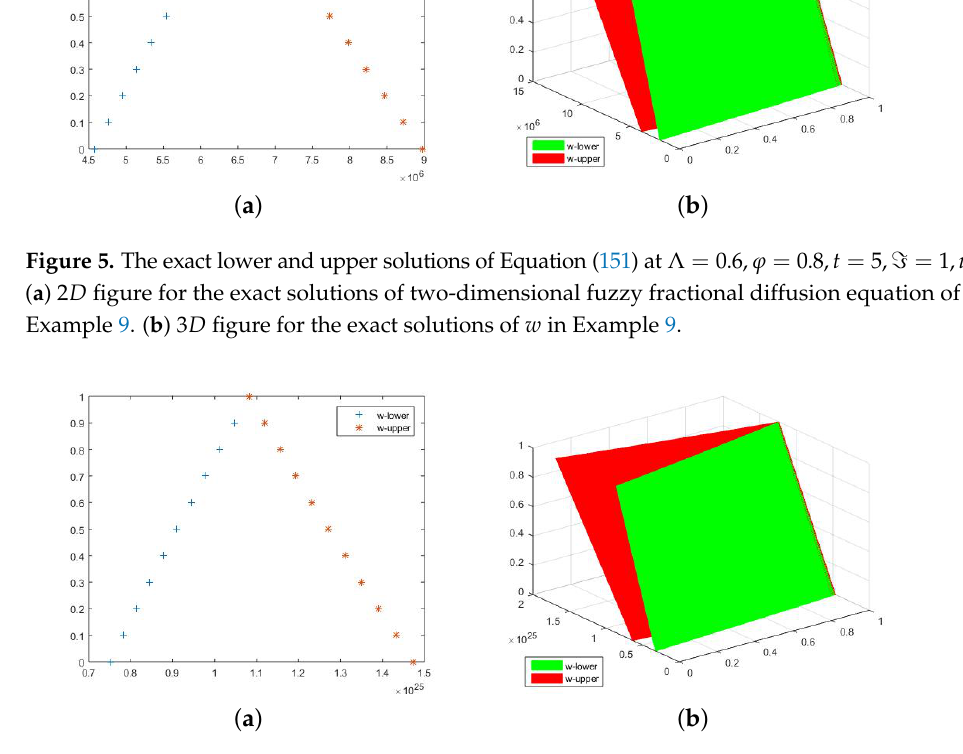
Figure 6. The approximate lower and upper solutions of Equation (151) at Λ = 0.6, ϕ = 0.8, t = 5, (cid:61) = 1/2, ı = 2. ( a ) 2 D figure for the approximate solutions of two-dimensional fuzzy fractional diffusion equation of w in Example 9. ( b ) 3 D figure for the approximate solutions of w in Example